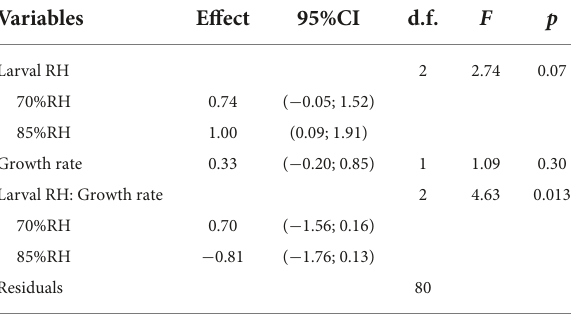
TABLE 3 Linear model analyzing the reproductive senescence of Tenebrio molitor females.